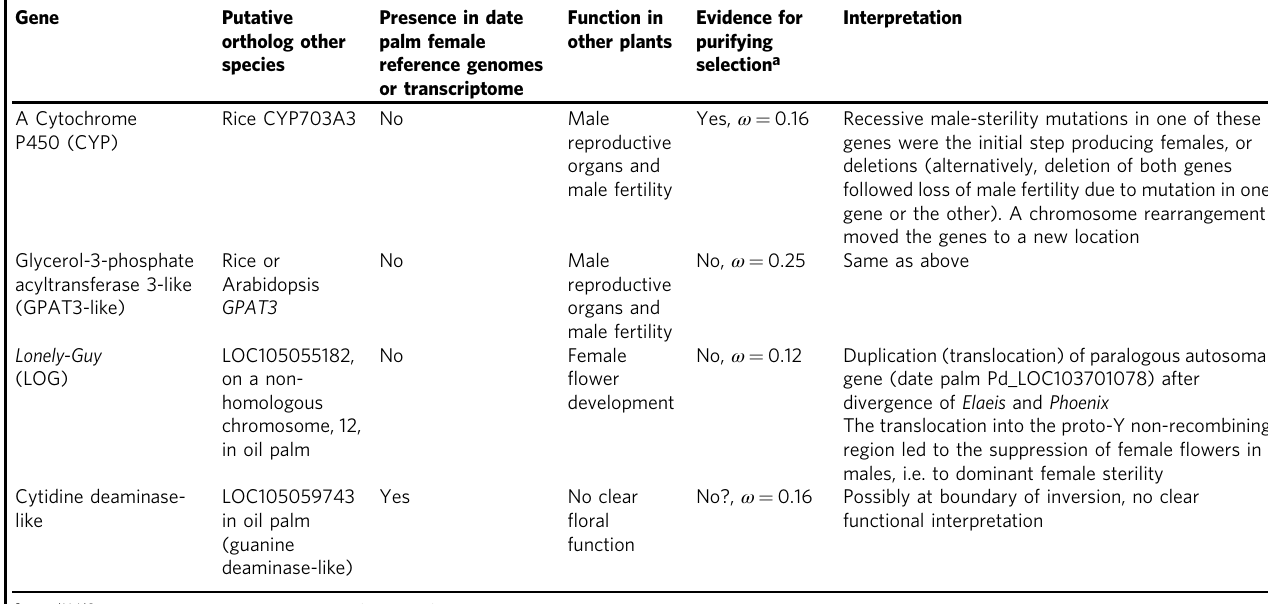
Table 2 Genes identi fi ed in this study